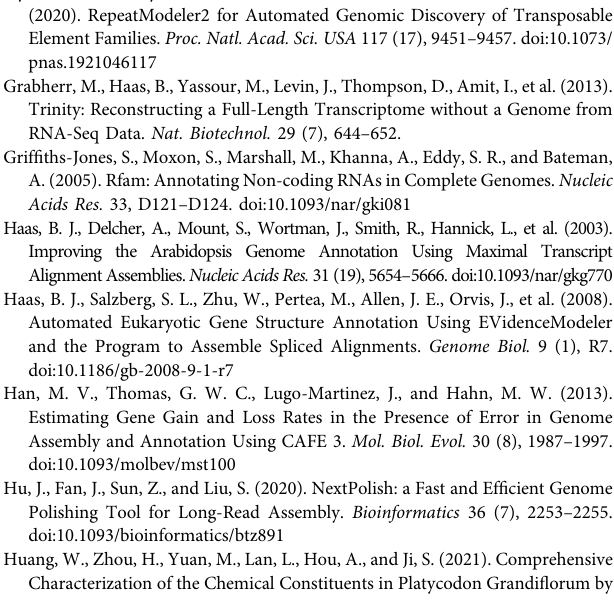
Figure and table preparation: YJ, WC, SC; Result